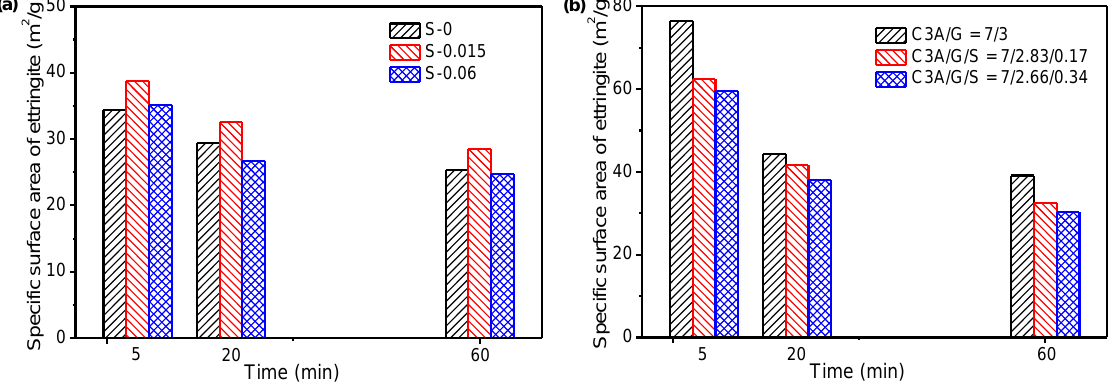
Figure 5. Specific surface area of ettringite precipitating along the C 3 A hydration: ( a ) effect of SO 4 2− concentration in simulated solution; ( b ) effect of Na 2 SO 4 in solid.